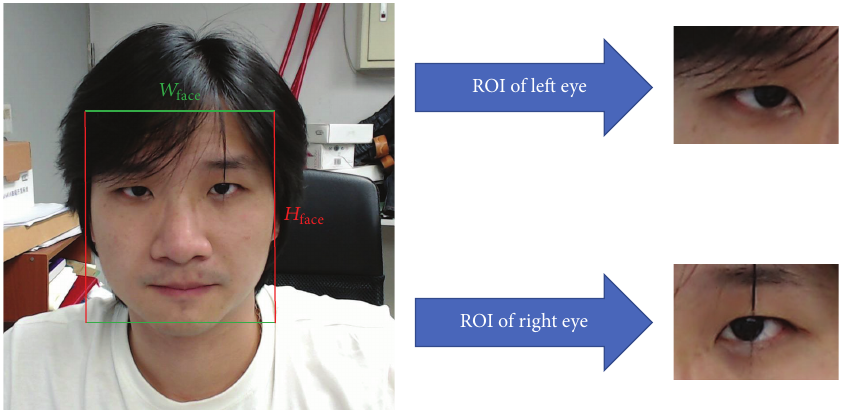
Figure 6: Illustration of the ROIs for detecting left and right eyes based on the detected face region [20].